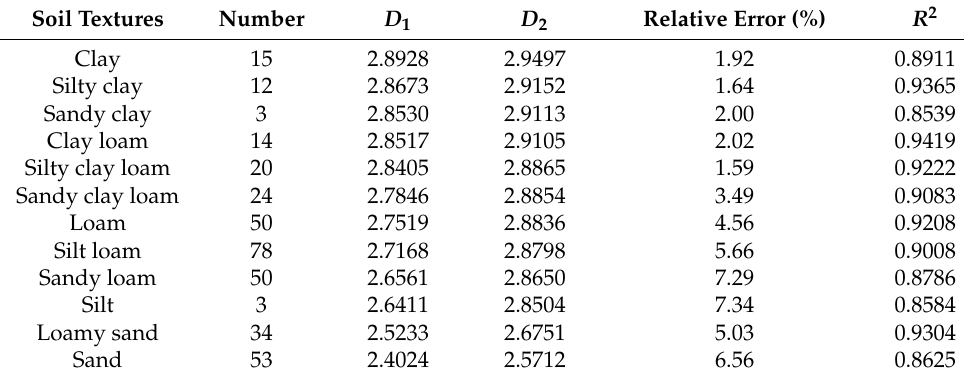
Table 4. Average estimated fractal dimension ( D 2 ) and mass fractal dimension ( D 1 ) values for 12 soil textures.